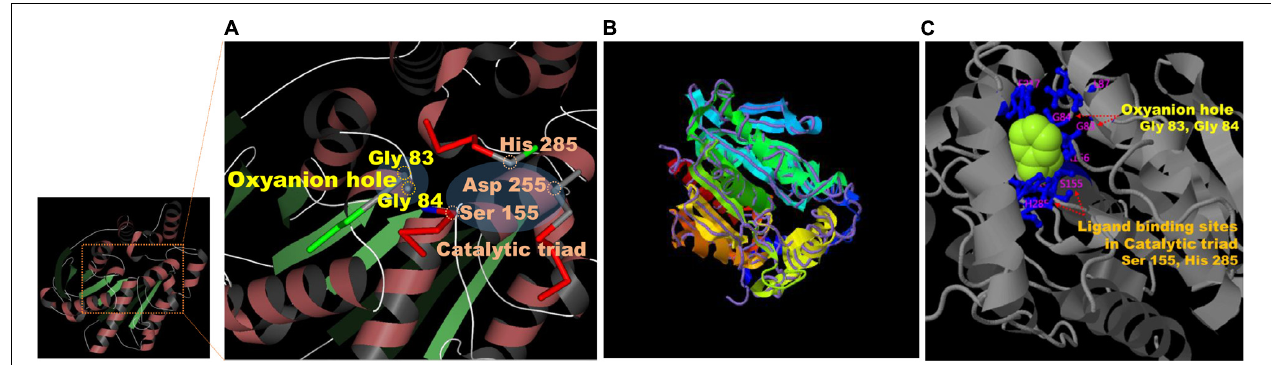
FIGURE 4 | (A) Model 2 structure and major residues based on the analysis of the SWISS-MODEL system (https://swissmodel.expasy.org). (B) The structural prediction of the model 3 (ribbon parameters) with the structurally most analogous protein (4YPV, purple line) in PDB using the I-TASSER system (https://zhanglab.ccmb.med.umich.edu/I-TASSER/). (C) Visualization of the combination between a phenylmethanesulfonic acid (PMS) and the major residues predicted to be important for ligand biding and activity of model 3 from the multiple function annotation analysis of the I-TASSER.